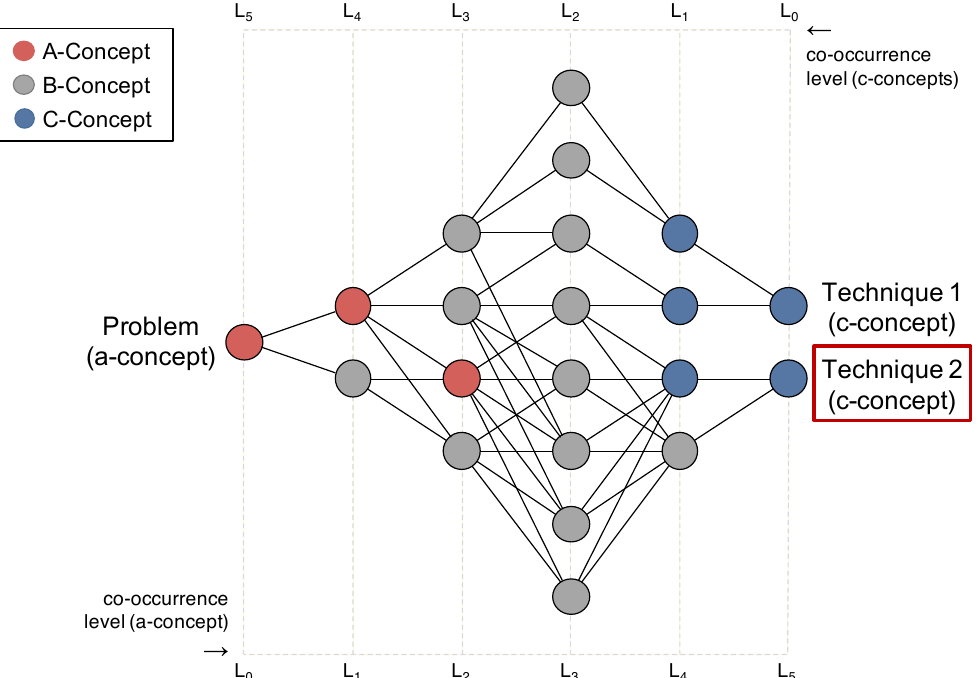
Figure 3. Co-occurrence network between a problem found in literature A and two